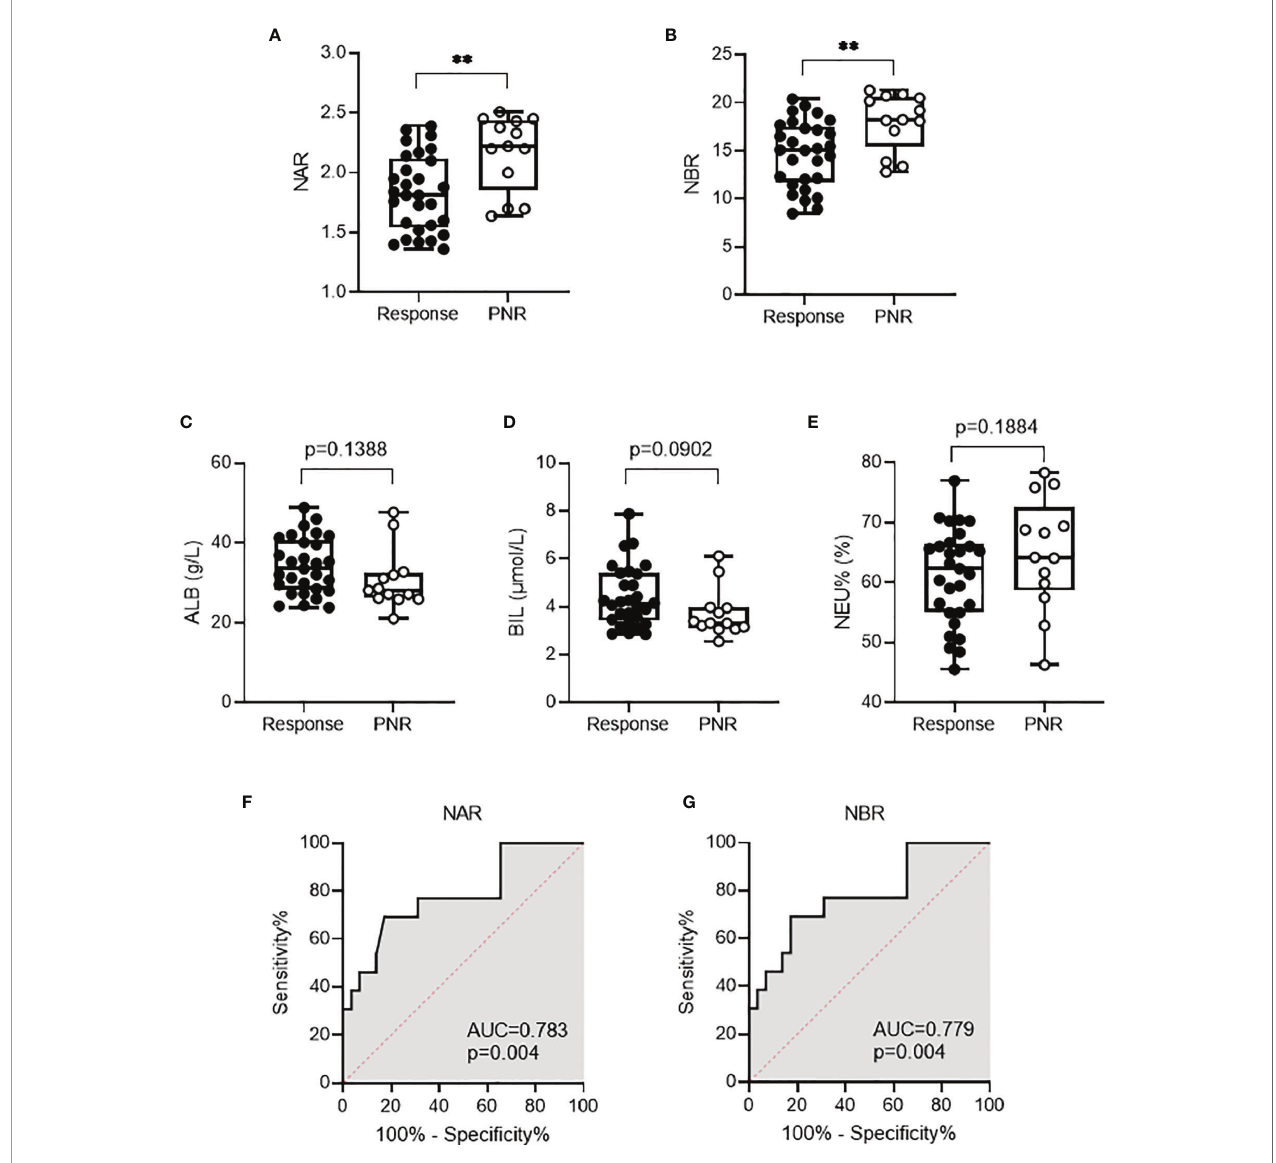
FIGURE 3 | NAR and NBR predict response to in fl iximab (IFX) in CD patients. CD patients (n = 42) received IFX induction therapy including 29 with complete or partial response and 13 with primary non-response. Differences of (A) NAR, (B) NBR, (C) ALB, (D) BIL, and (E) NEU were determined between patients with initial response to IFX and those who had primary non-response. **p < 0.01, Student ’ s t test (unpaired, two-tailed) was performed. Abilities of (F) NAR and (G) NBR to discriminate IFX responders from primary non-responders were determined by ROC curve analysis was performed. p < 0.05 was considered signi fi